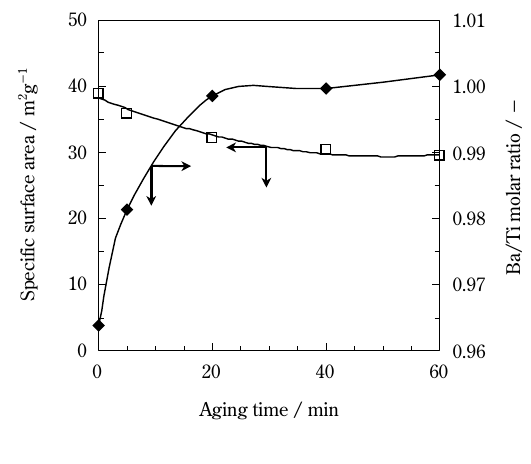
Fig. 3 Effect of aging time on the surface area and the Ba/Ti molar ratio of BaTiO 3 particles prepared by sol-gel method (Flow rate (cid:3) 0.73